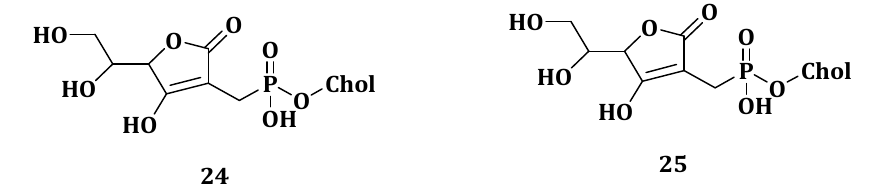
Figure 12. Chemical structures of compounds 24 and 25 .